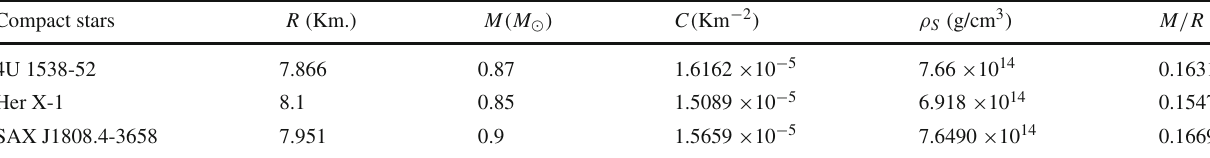
Table 4 The numerical values of the masses–radius ( M / R ) and surface density (ρ S ) for the compact star candidates Compact